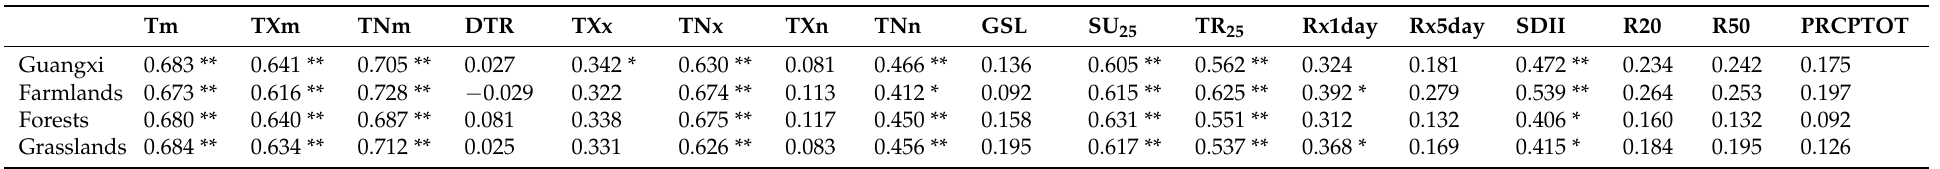
Table 4. Correlation coefficients between the regional mean NDVI and the extreme temperature (precipitation) indices on an annual scale during